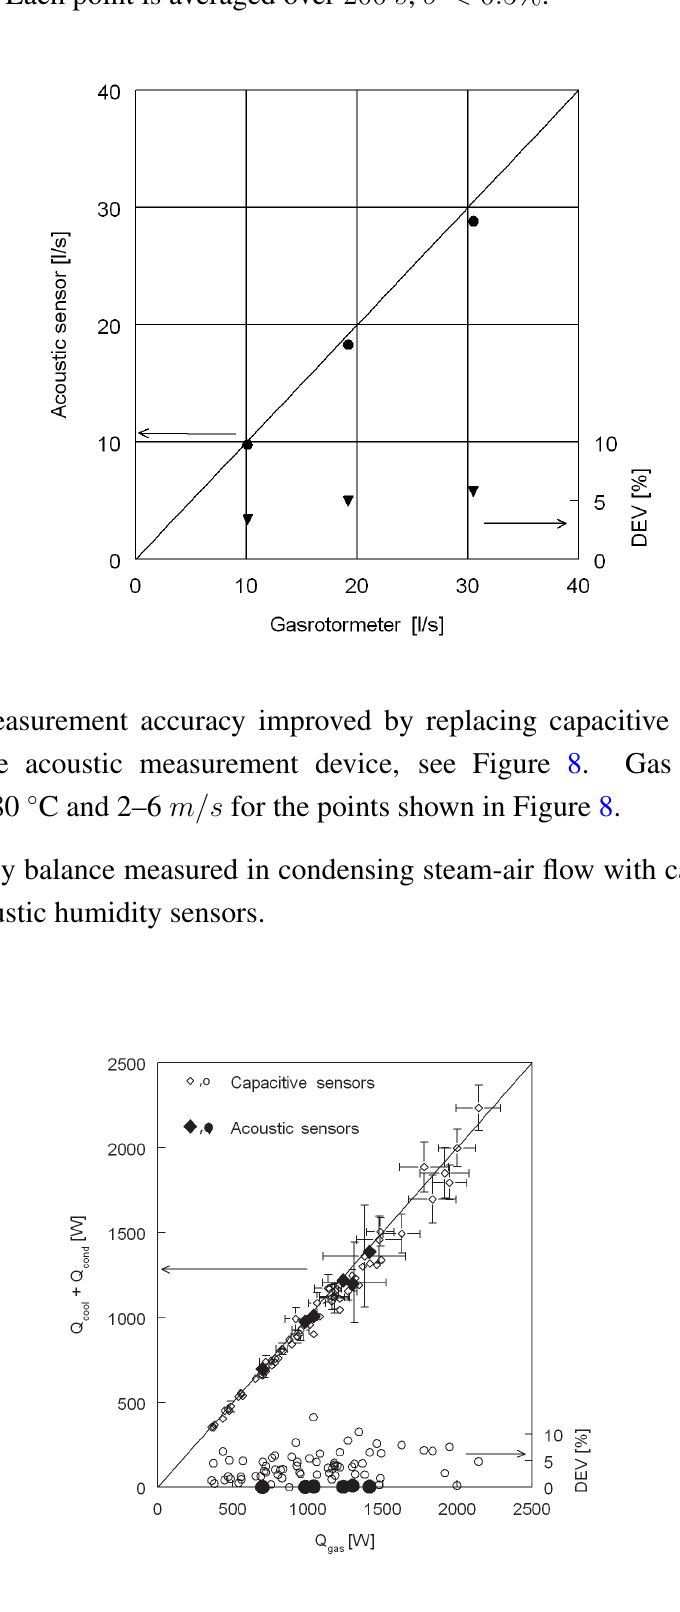
Figure 7. Volume flow rate of acoustic sensor calculated from average velocity in duct with A = 2 . 34 · 10 − 3 m 2 vs. volume flow rate in a gasrotormeter. Corresponding mean velocities are 4 − 12 m/s . Each point is averaged over 200 s , σ < 0 . 5% .